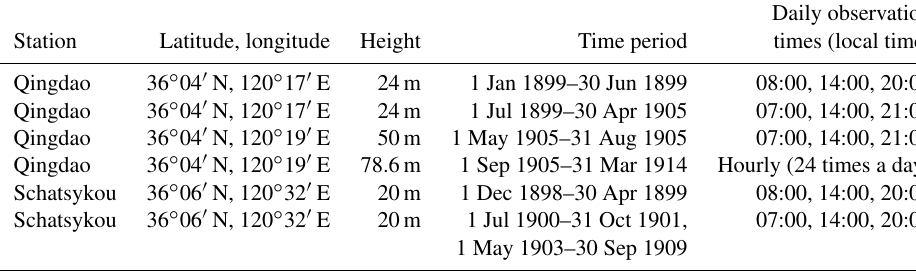
Daily observation